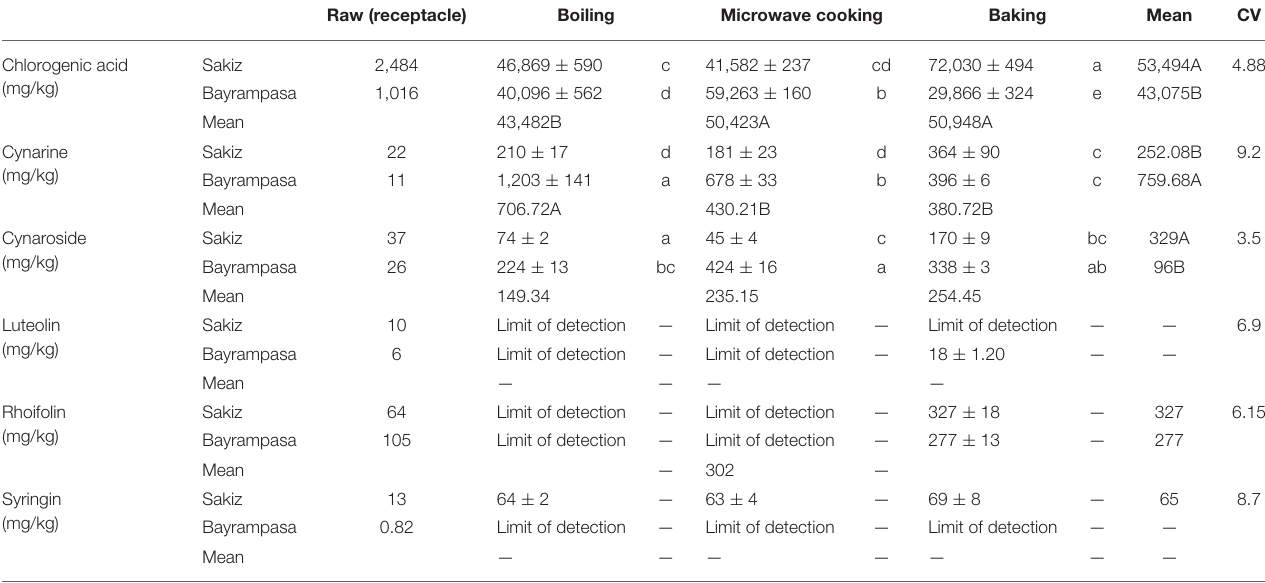
TABLE 4 | Phenolic substance content of raw and cooked artichokes. Raw